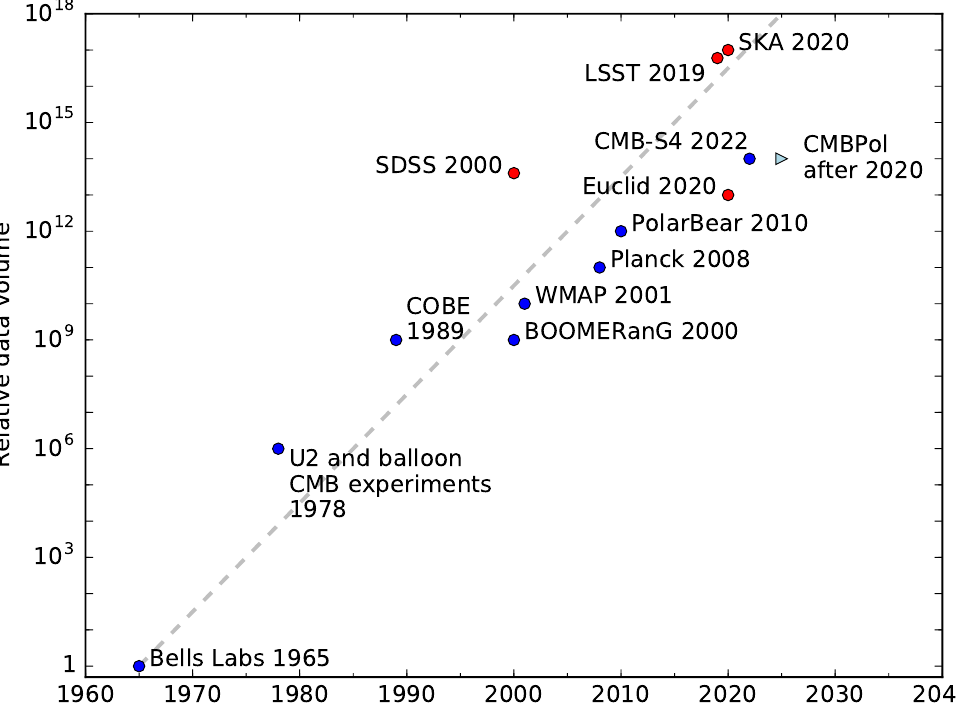
Figure 8. The growing data volume of experiments. The data volume of each experiment is shown as an order-of-magnitude multiple of the data volume of the 1965 Bells Labs experiment which detected the CMB. The labels show the year of ‘first light’ for each experiment. CMB surveys are marked by blue dots, while red dots show large-scale structure surveys. A first light date for CMBPol (light blue triangle) has not yet been fixed. Note that the vertical axis is logarithmic: the date volume increases about a thousandfold every ten years (grey dashed line). Note too that we plot CMB, large-scale structure, space and ground-based probes on the same graph. Ground-based probes will always tend to have a larger data volume than space-borne probes, due to the bandwidth limit on data transmission from spacecraft. Longer-running experiments will also have a larger data